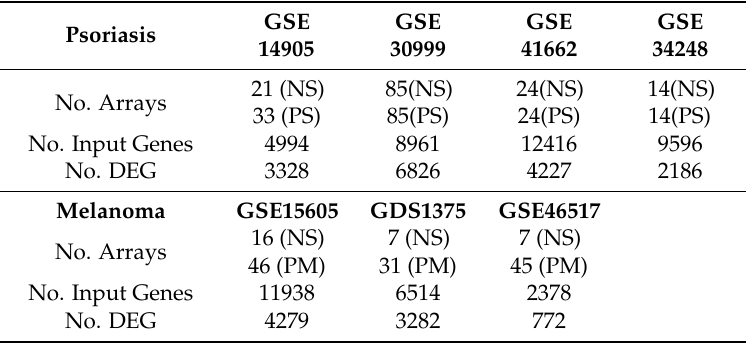
Table 1. Microarray datasets: Four datasets on psoriasis and three datasets on melanomas